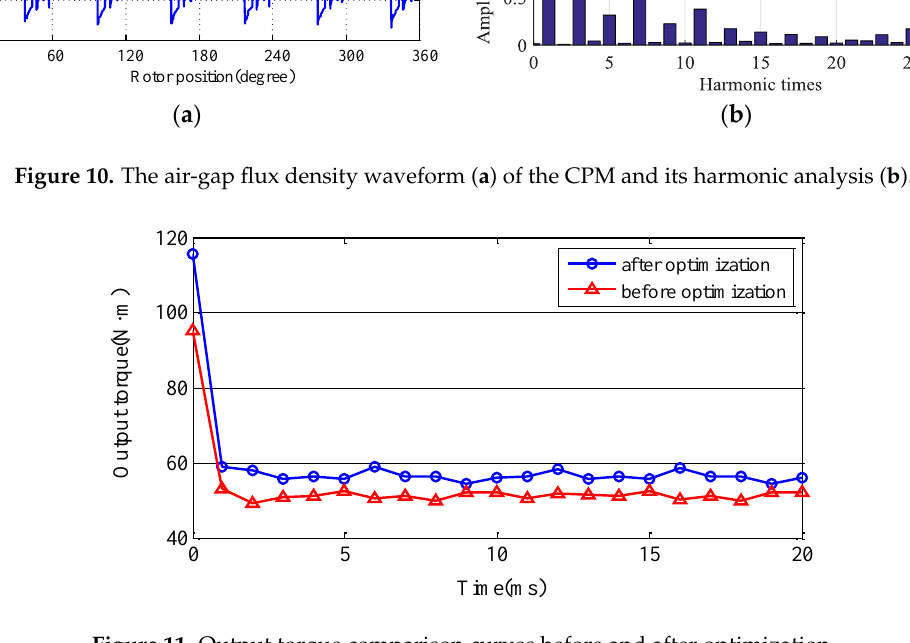
Figure 12. Cogging torque curves with different materials.